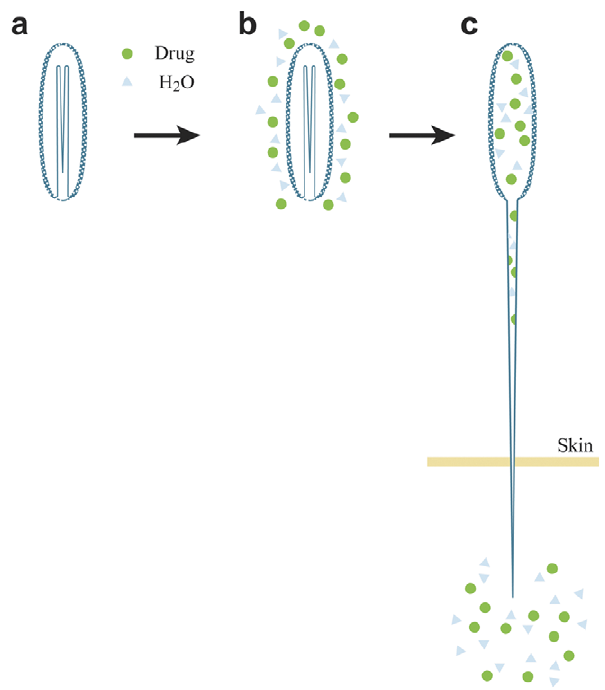
Figure 1. Mode of action of the cnidocyst system. The intact dry cnidocyst (a) is activated by the hydrophilic drug solution (b) water molecules (blue triangle) and the soluble drug (green circles) penetrate the porous wal l of the cnidocyst, resulting in discharge of the tubule and injection of its microcapsule content through the tubule to the skin (c).